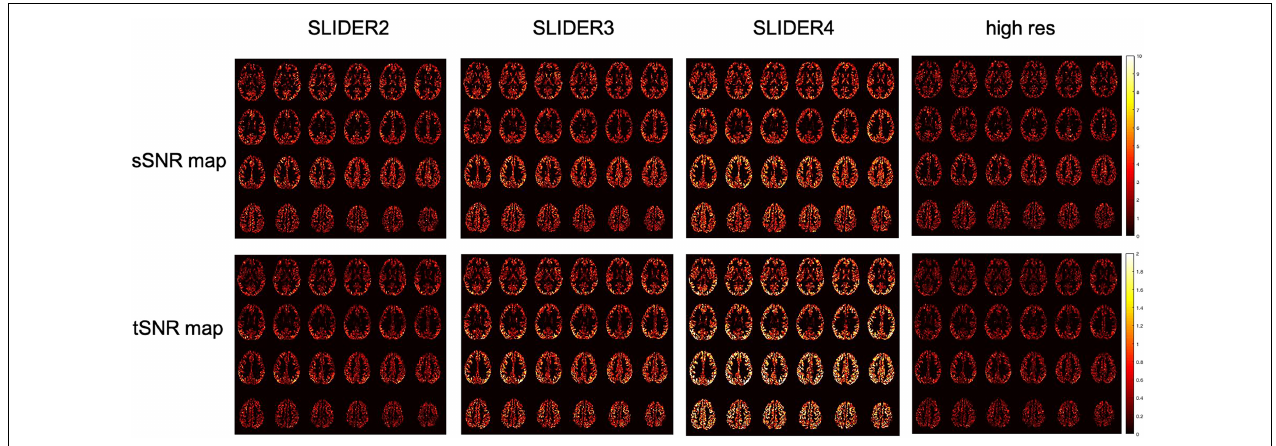
FIGURE 6 | Spatial SNR (sSNR) map and temporal SNR (tSNR) map of a representative subject in different SLIDER conditions and reference ASL scan.